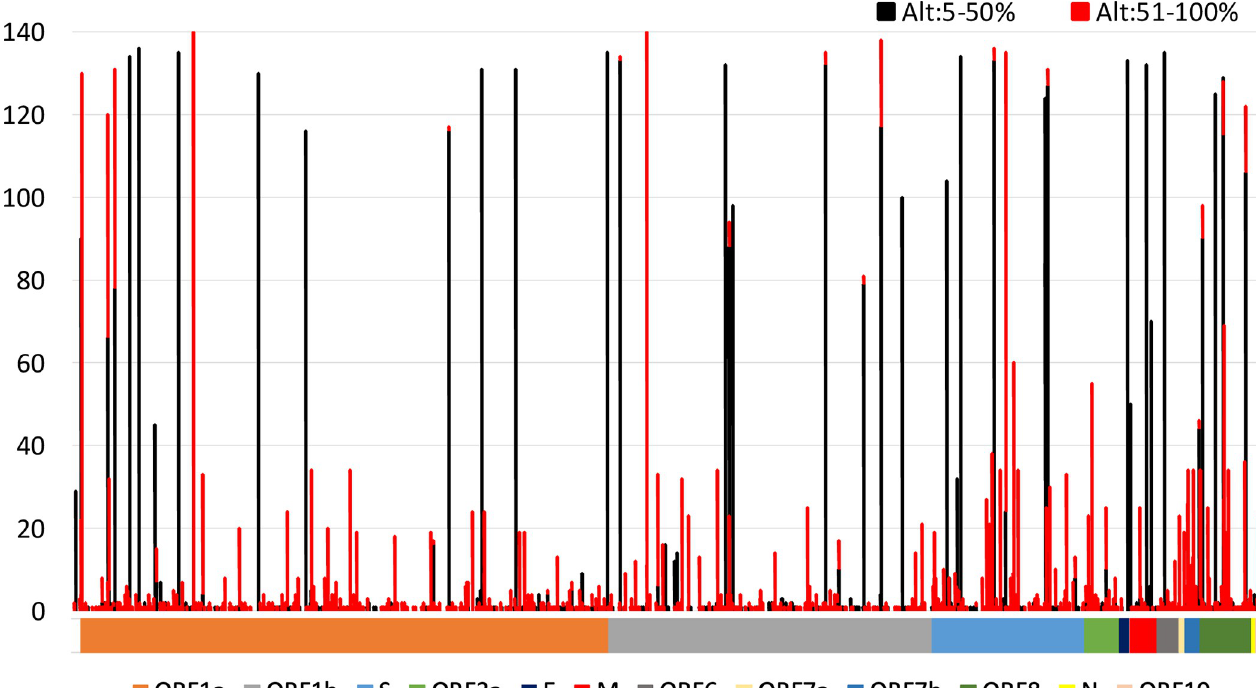
Fig 4. Summary of the Distribution of SARS-CoV-2 Sequence Variation and Heterogeneity. Counts of samples observed to show variation (among the 140 meeting analytical threshold) across the SARS-CoV-2 genome. Black histogram components include those positions where biallelic variation was observed at or below 50% and may not have been included in reported consensus sequences. Red histogram components identify positions and occurrences where the alternate allele was observed at proportions from 51–100% and would have been included in the reported consensus sequence. The multicolored bar below the graph identifies genomic segments encoding different SARS-CoV-2 genes designated in the legend (ORF–Open Reading Frame; S–Spike; E–Envelope; M = Membrane; N–Nucleocapsid). Quantitative details summarized in Fig 4 are available in S2A to S2B Table.